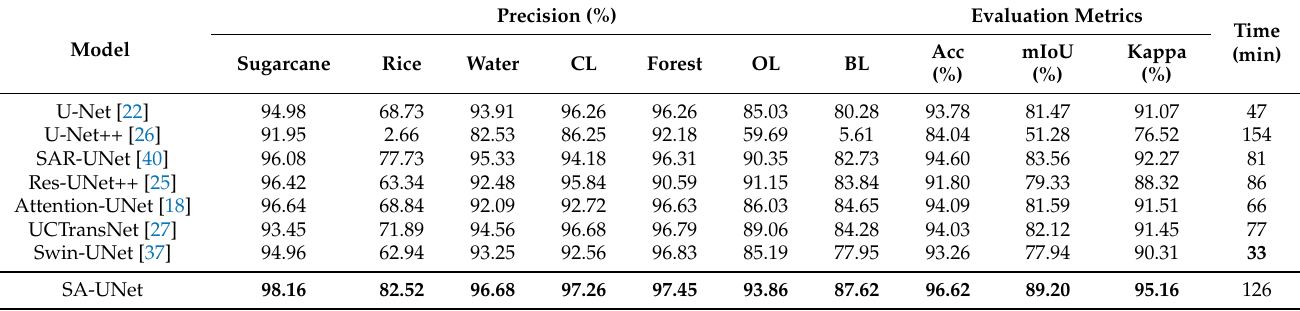
Table 6. Comparison of segmentation results of test sets in the dataset II by different methods.